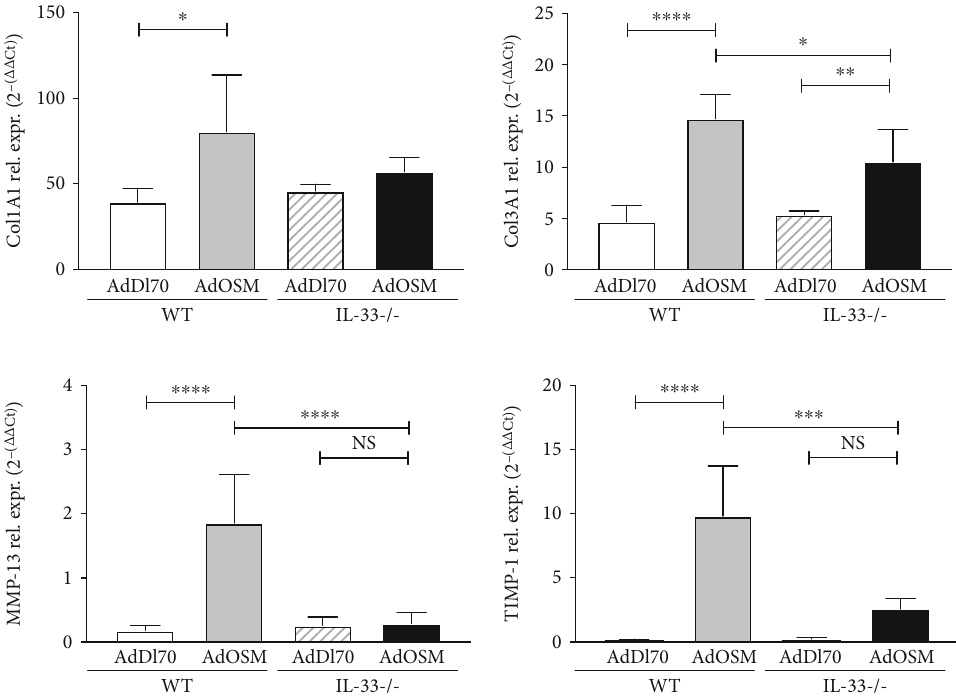
Figure 6: Col1A1, Col3A1, matrix metalloproteinase-13 (MMP-13) and tissue inhibitor of matrix metalloproteinase-1 (TIMP-1) expression in the lungs of wild-type and IL-33-/- mice. C57Bl/6 wild-type (WT) or IL-33-/- mice were endotracheally administered AdDl70 (control) or AdOSM, sacri fi ced at day 7, and lung homogenates examined for mRNA expression of extracellular matrix genes Col1A1, Col3A1, and matrix proteinase and proteinase inhibitor genes MMP-13 and TIMP-1. Expression was assessed by quantitative real-time PCR. Rel. expr.: relative expression. ∗ p < : 05 , ∗∗ p < : 01 , ∗∗∗ p < : 001 , ∗∗∗∗ p < : 0001 . N = 5/group .